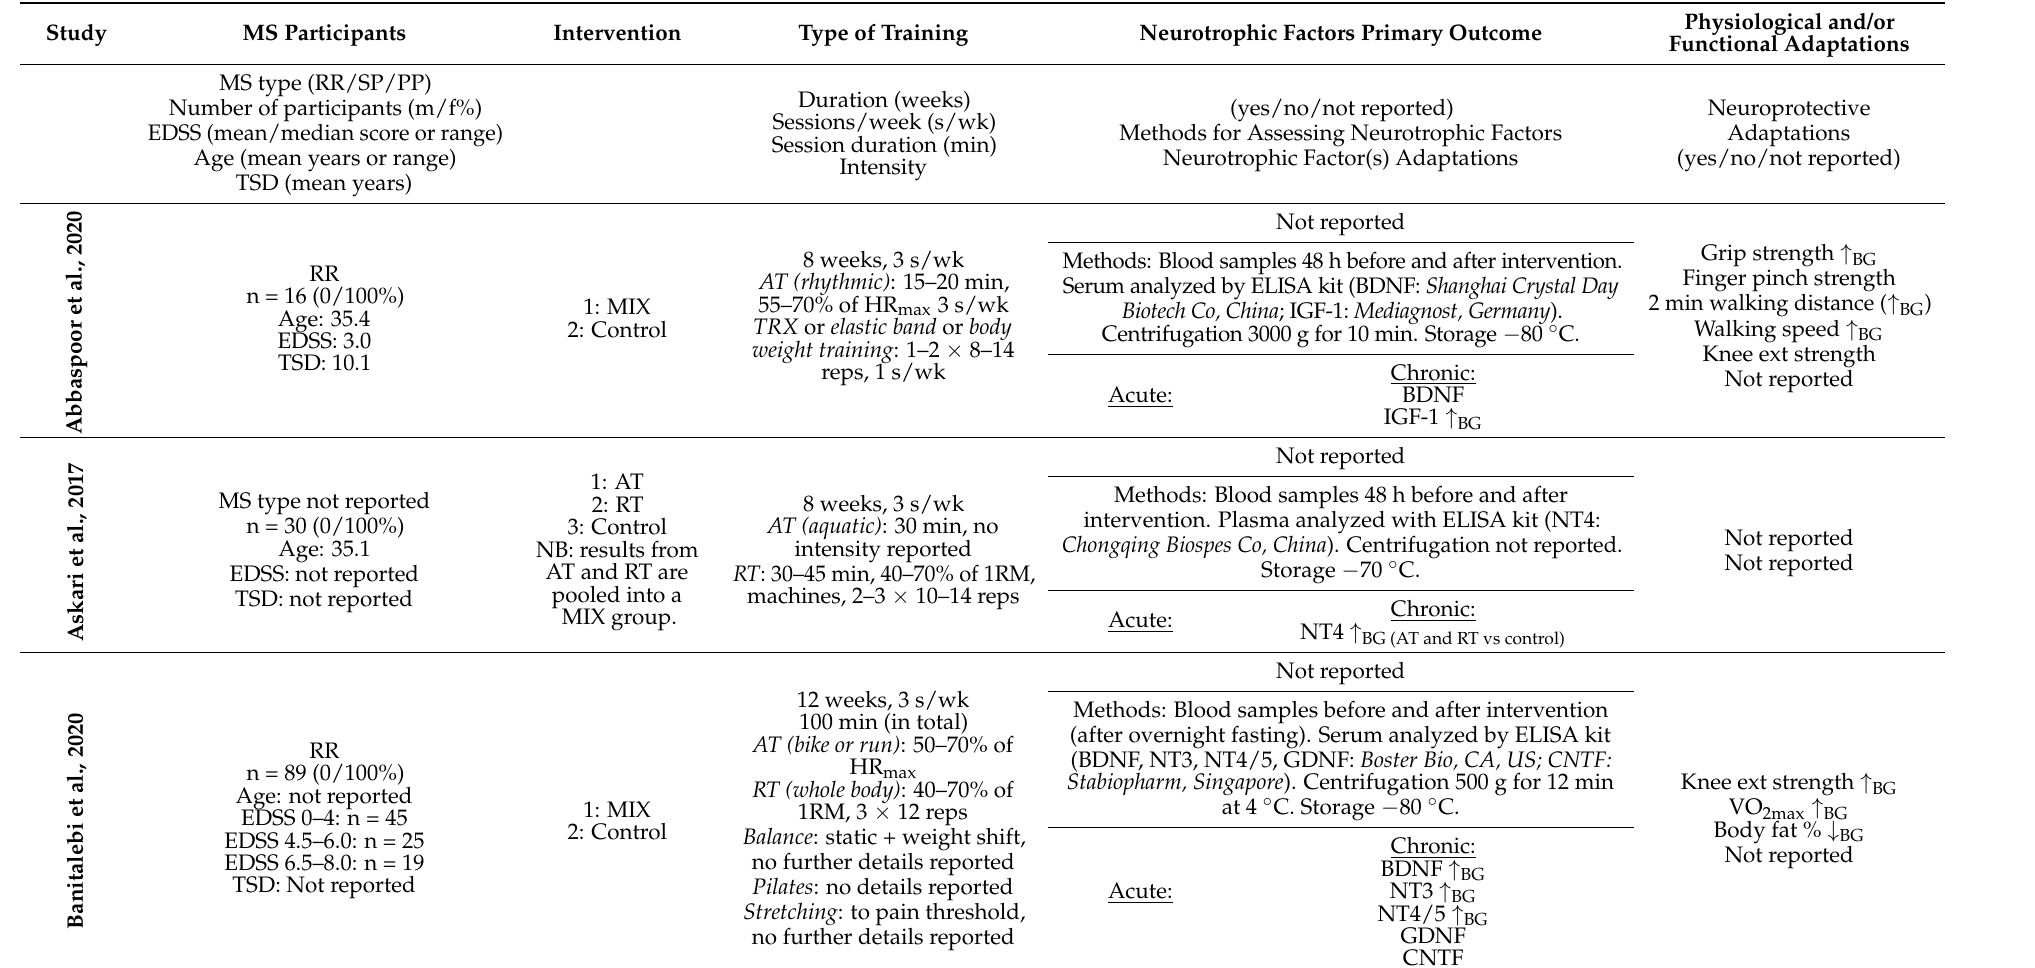
Table 2. Summary of study